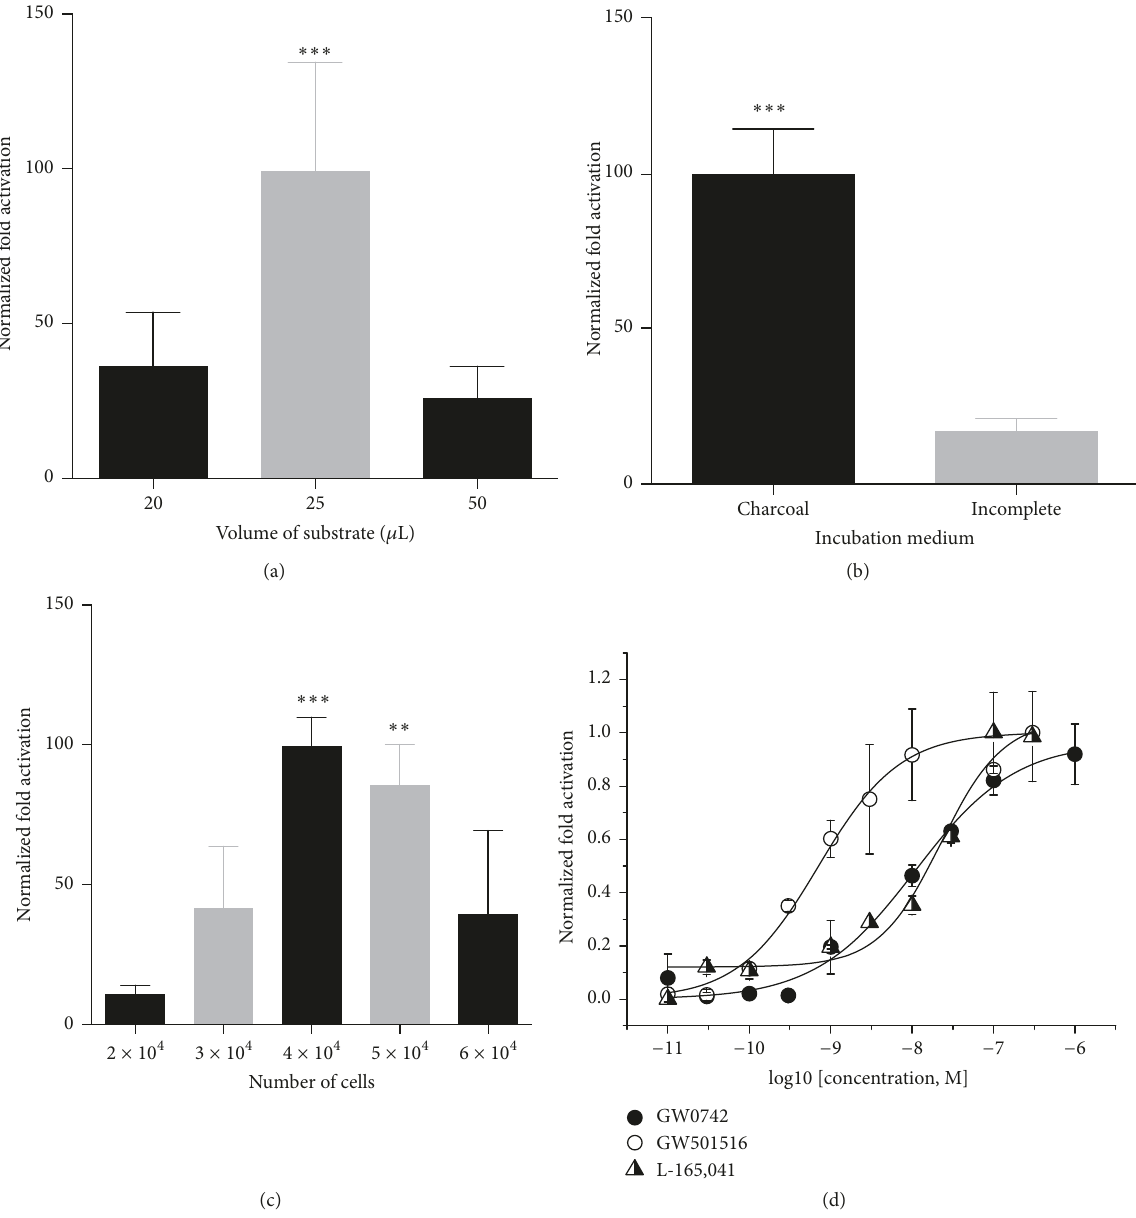
Figure 2: Optimization of the screening protocols. When not specified, the positive control was 1 𝜇 M of GW0742 and the number of cells was 4 × 10 4 cell/well. Bar graphs represent the specific fold activation normalized by the highest activation presented as the mean ± SD. 𝑝 values were calculated by the unpaired 𝑡 -test ( ∗∗ 𝑝 < 0.01 and ∗∗∗ 𝑝 < 0.001 ). All bar graphs and calculations were performed with GraphPad Prism. (a) Evaluation of substrate volumes. Cell lysis was performed in 20 𝜇 L of passive lysis buffer, and the volumes of LAR II and Stop & Glo substrates were varied (50, 25, and 20 𝜇 L). The results show that the best signal of PPARß/ 𝛿 activation was measured with 25 𝜇 L of each substrate. The data is from one experiment with 6 technical replicates. (b) Evaluation of the best ligand incubation medium. In this test, 293T cells were incubated with GW0742 in 10% charcoal-stripped FBS DMEM (charcoal) or in DMEM (incomplete), and the activation fold of PPARß/ 𝛿 was measured in each condition. 𝑍 󸀠 -factor charcoal = 0.62; 𝑍 󸀠 -factor incomplete = 0.21. Charcoal-supplemented medium was chosen as the best option for our assays, and this medium composition was used in the ligand screening for PPAR 𝛽 / 𝛿 . One representative experiment is shown out of three independent replicates. (c) Evaluation of the number of cells per well. Cells were seeded at 2 × 10 4 , 3 × 10 4 , 4 × 10 4 , 5 × 10 4 , and 6 × 10 4 cells per well, and the activation fold of PPARß/ 𝛿 was measured in each condition to determine the best quantity of cells in each assay. Based on these results, we chose 4 × 10 4 cells per well to perform PPARß/ 𝛿 ligand screening. One representative experiment is shown out of four independent replicates. (d) PPARß/ 𝛿 dose-response activation in the presence of the commercial agonists (GW0742, GW501516, and L-165,041). Concentrations varied from 10 −11 to 10 −6 M. Data are expressed as the normalized activation fold as 1 (maximum activation) and 0 (vehicle-treated cells) and represent the mean of 2 independent experiments with 3 technical triplicates. Graphs and dose-response calculations were performed in OriginPro 8.0. GW0742: 𝑅 2 = 0.98549 and EC 50 = 1.08708 𝐸 − 8 ; GW601516: 𝑅 2 = 0.98028 and EC 50 = 7.10385 𝐸 − 10 ; L-165,041: 𝑅 2 = 0.9725 and EC 50 = 2.23969 𝐸 − 8